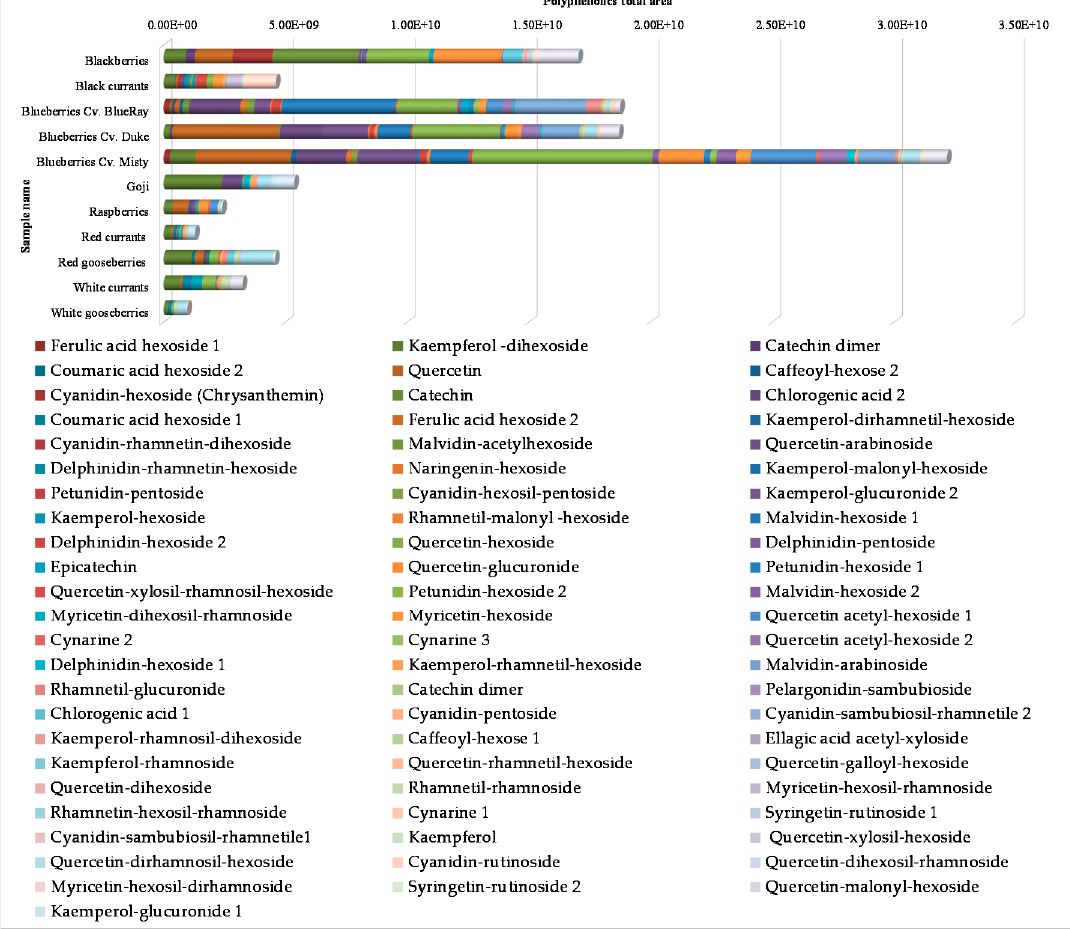
Figure 1. Histogram of the 70 different analytes found in the 11 berry fruits investigated.